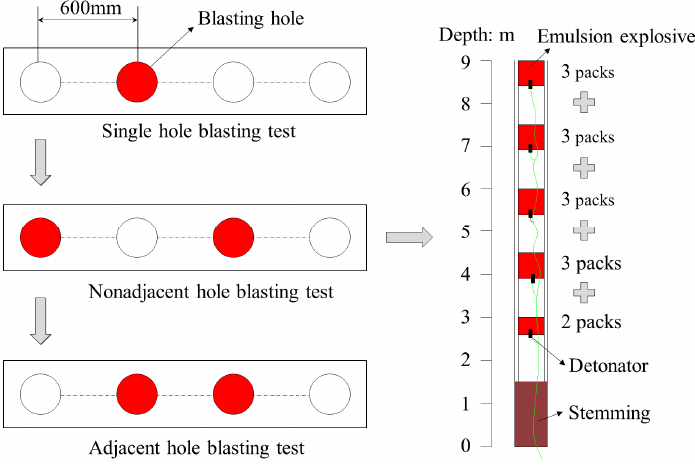
Figure 16. Roof fracturing test and charging parameters.